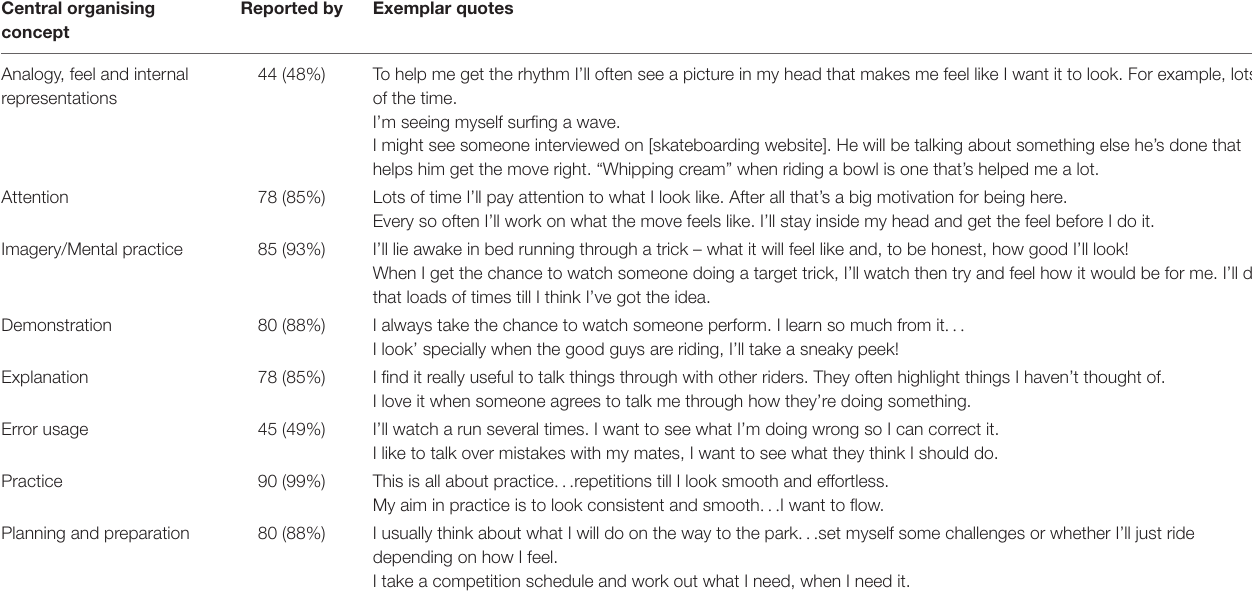
TABLE 1 | Participants reported use of learning